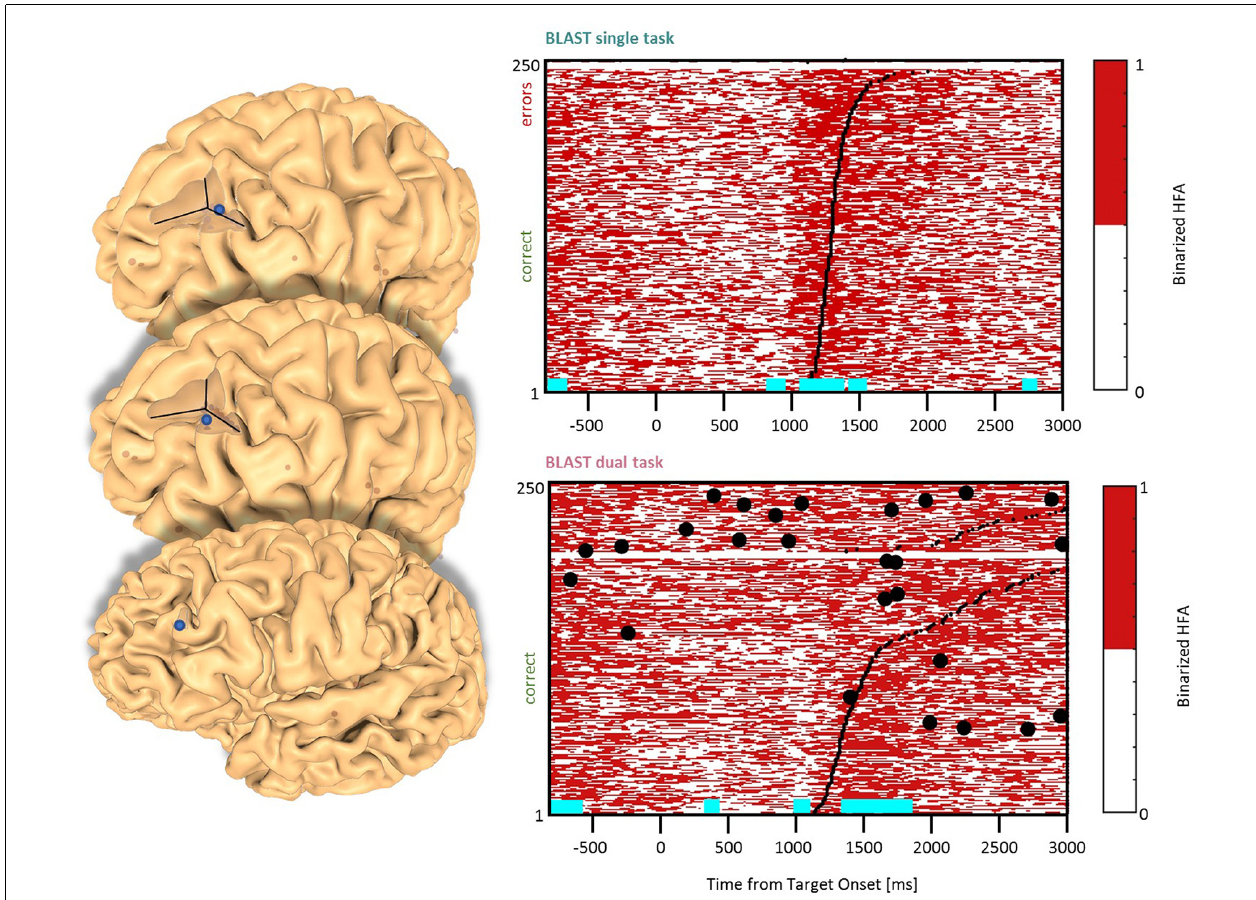
FIGURE 5 | Interference in the Dorsolateral Prefrontal Cortex. Sites with interference between T1 and T2 are displayed at their precise anatomical location onto a 3D representation of the participant’s brain. The matrix representation reproduces the display of Figure 2 , for the single-task and dual-task conditions for one of the sites. Patients id [Px] and iEEG site names, from left to right and top to bottom: F’9 [P4] (matrix displayed); Y’13 [P4]; G’12 [P9].